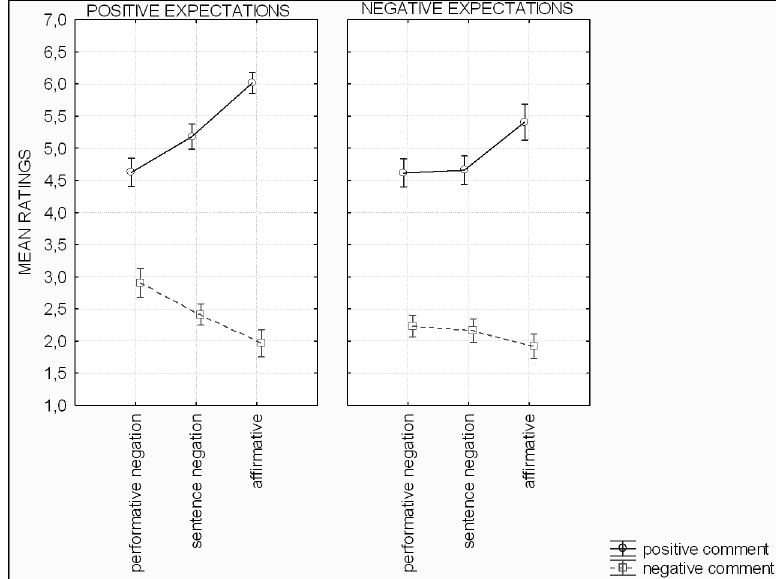
Figure 1. Intended meaning rating for affirmative, performative negation and sentence